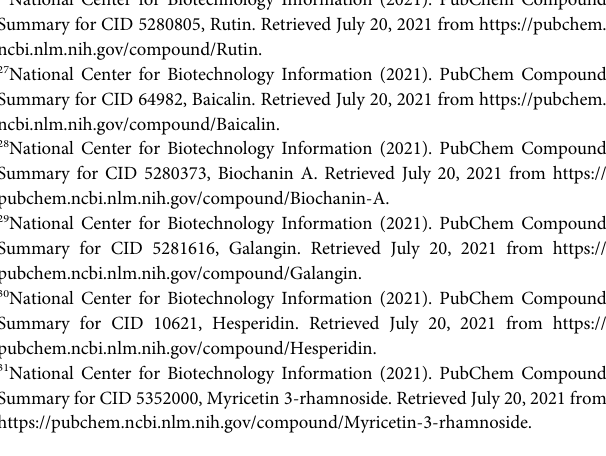
weak anti-DENV-2 (daidzein exhibited antiviral activity after adsorption the virus to Vero cells; naringin blocked attachment and adsorption effects), or no antiviral activity at all like hesperetin ( Figure 3H ) (Zandi et al., 2011).